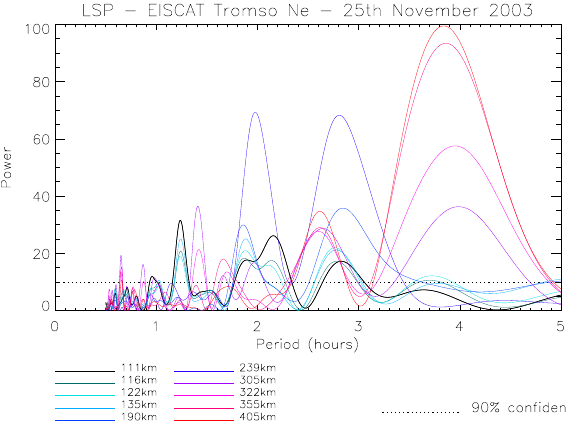
Fig. 14. Lomb-Scargle Periodogram from EISCAT electron densi- ties from the 25 November 2003. Colours are for different heights along the Tromsø